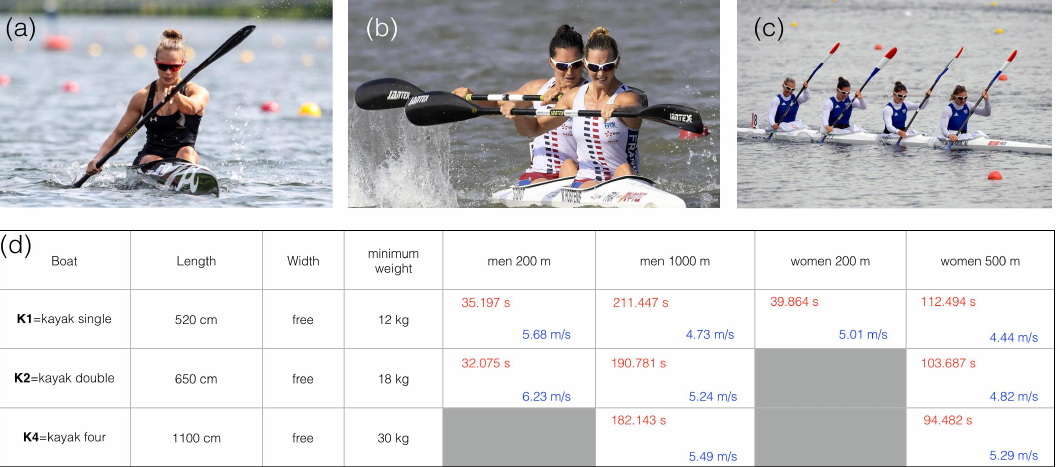
Figure 1. ( a ) K1 women’s kayak race, ( b ) K2 women’s kayak race, ( c ) K4 women’s kayak race, ( d ) presentation of the 9 Olympic events in kayaks at the Rio 2016 Olympic games with corresponding boat characteristics. The time of the winner is indicated in red and the corresponding mean velocity in